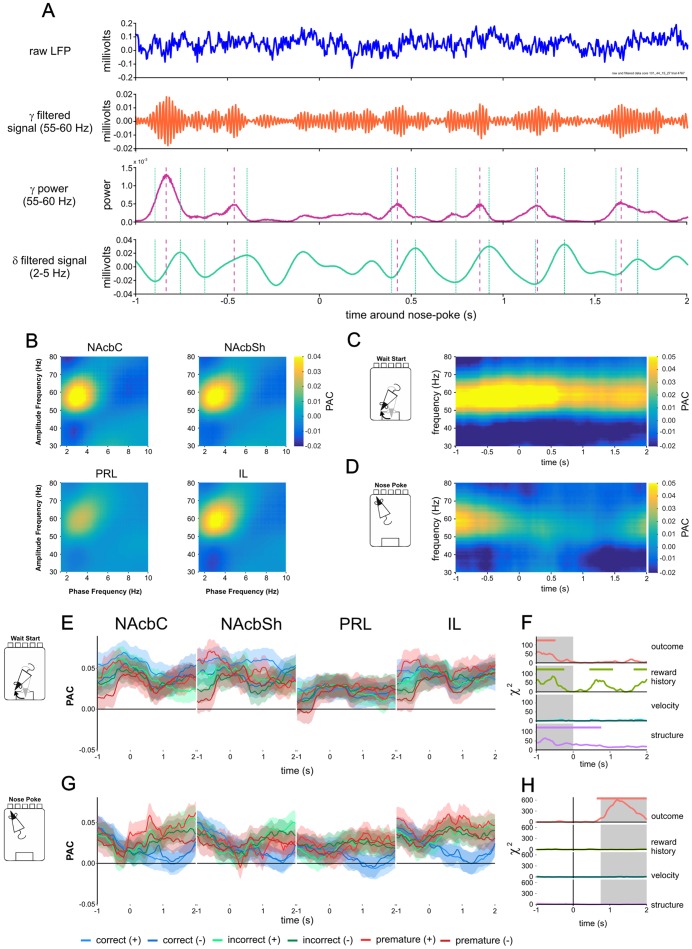
Corticostriatal gamma60-delta PAC during 5-CSRTT performance.A) Example of raw and filtered LFP data showing PAC. Vertical dashed purple lines indicate local gamma60 power maxima; vertical green lines indicate local delta peaks and troughs. B) Phase-amplitude coupling between low (phase giving) and high frequency (amplitude giving) oscillations in PFC and NAcb calculated over whole 30 minute recordings. PAC peaked between gamma60 oscillations and a 2–3 Hz delta oscillation, and was weaker in PRL than other regions. Note that PAC was calculated with amplitude and phase data taken from the same electrode. C) PAC between 30–80 Hz high frequency oscillations and a 2.75 Hz delta oscillation around wait-start for all correct, previously rewarded trials recorded from NAcbC electrodes. D) PAC between 30–80 Hz and 2.75 Hz delta oscillations around nose-poking for all correct, previously rewarded trials recorded from the NAcbC. E) Gamma60-delta PAC around wait-start. Solid lines represent the mean of all trials. Shaded areas represent the SEM. F) Model statistics for the effect of upcoming trial outcome, previous reward, velocity and brain region on instantaneous gamma60-delta PAC around the wait-start alignment event. G) Gamma60-delta PAC around nose-poking. Solid lines represent the mean of all trials. Shaded areas represent the SEM. H) Model statistics for the effect of upcoming trial outcome, previous reward, velocity, and brain region on instantaneous gamma60-delta PAC around nose-poking.